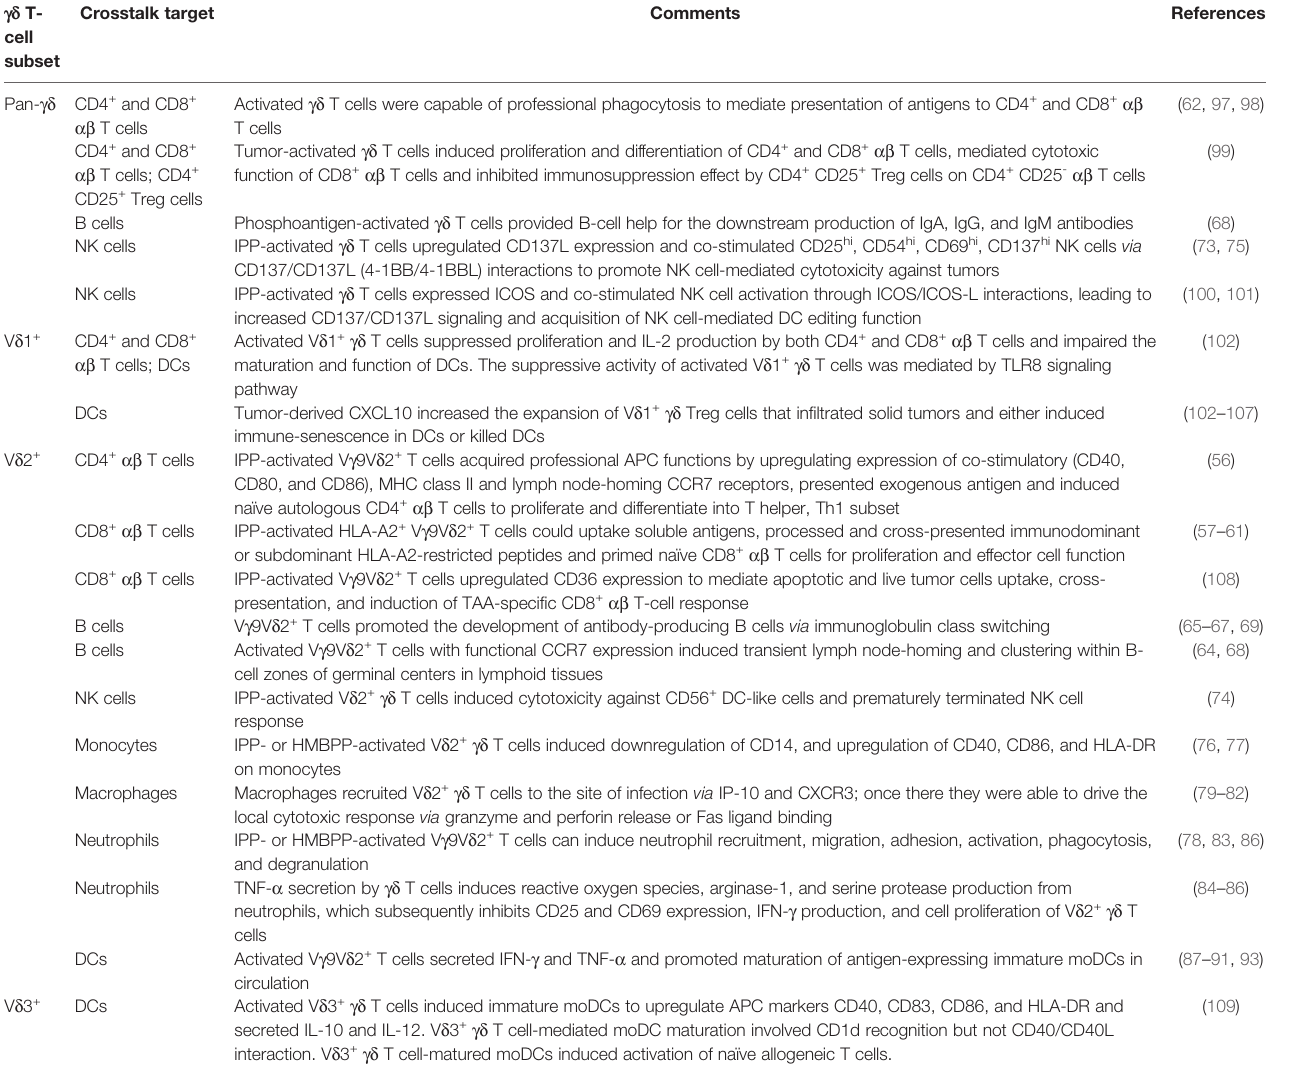
TABLE 1 | Summary of distinct gd T-cell subset interactions with other immune cells. gd T-